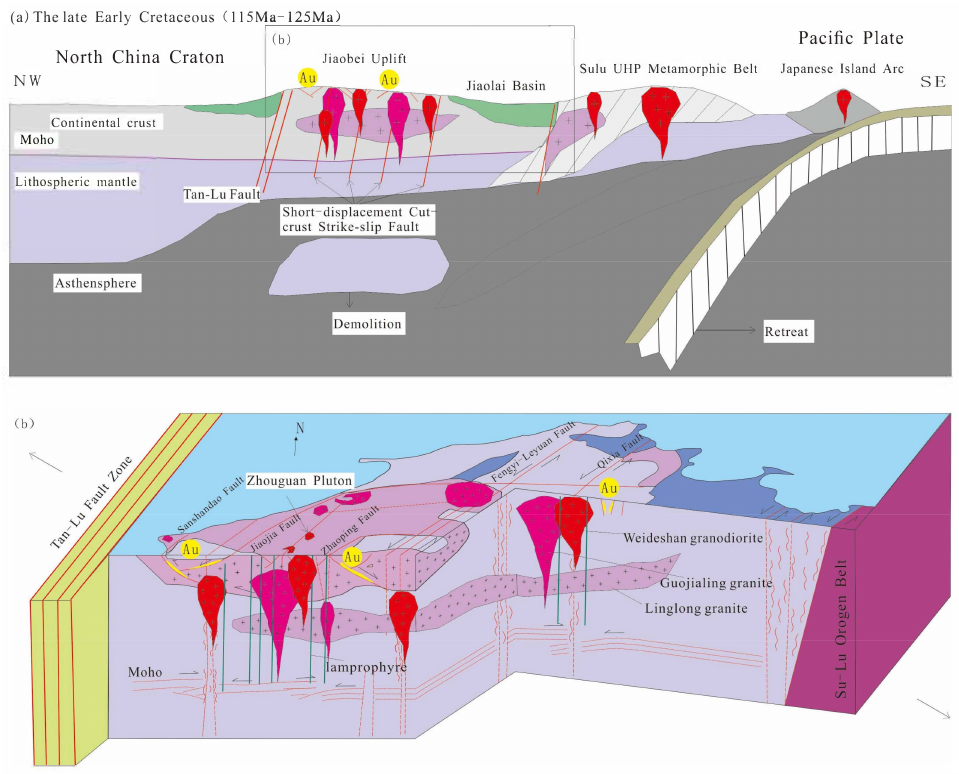
Figure 14. Geodynamic mechanism of magmatic activity ( a ) (after Song et al., 2020 [82]), diagram showing structural pattern in Jiaodong ( b ) (Yu et al., 2018